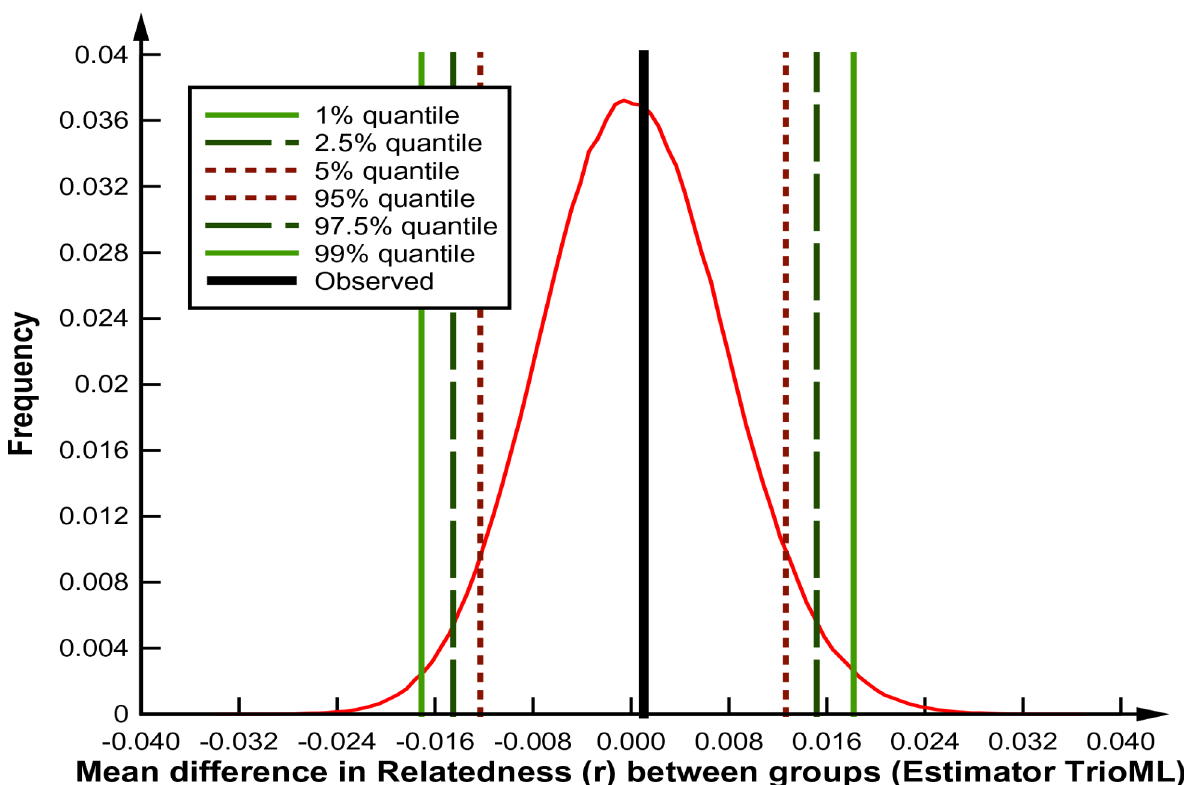
Fig 8. Test of differences in mean relatedness ( (cid:22) r ) among beluga whales within a single year compared to (cid:22) r between whales from two different years for the same summering ground using COANCESTRY . The graph depicts results for Kasegaluk Lagoon 1988 compared to 1988–2007 using the ML estimator TrioML of Wang (2007). If the observed difference (black line) falls outside the 90% (dotted lines), 95% (dashed lines), and 99% (green solid lines) confidence intervals from the bootstrap analysis distribution the difference is adjudged to be significant.